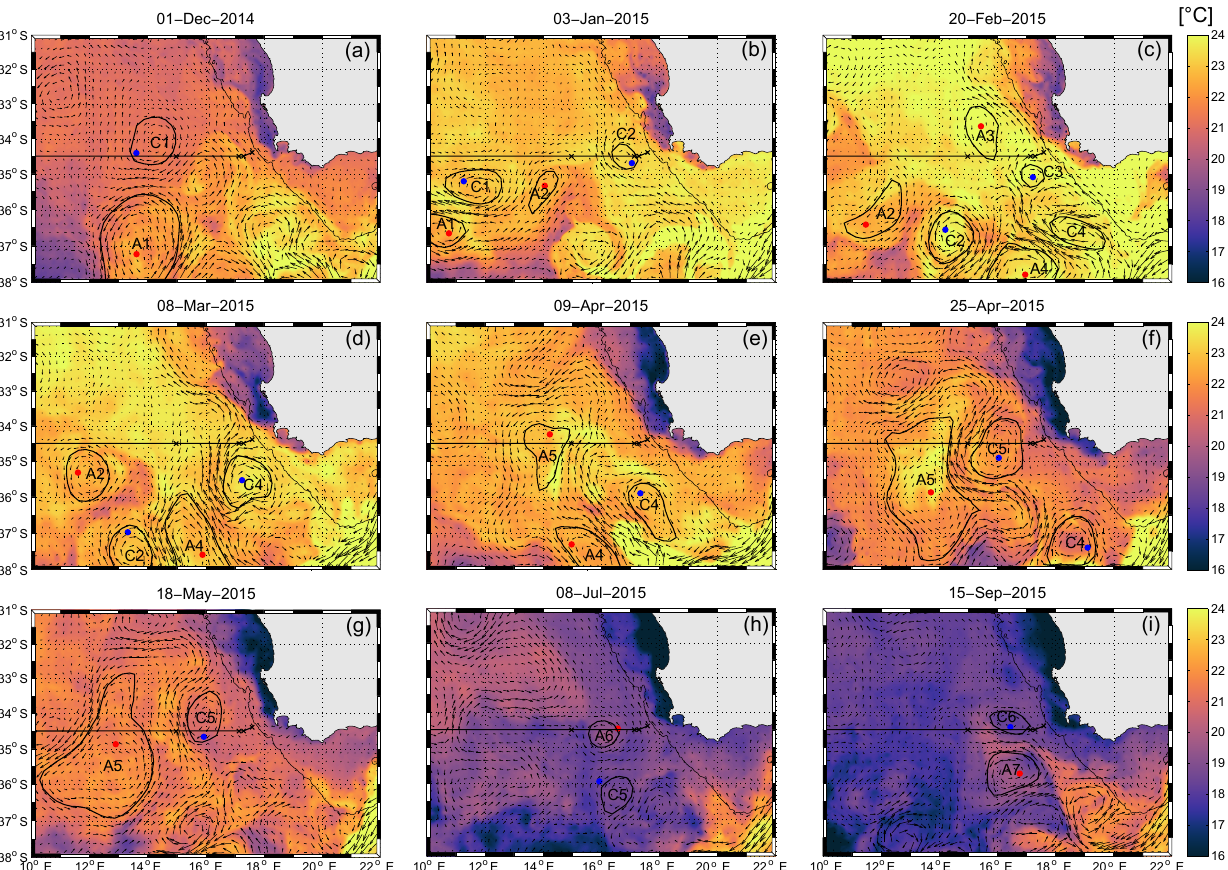
Figure 6. SST satellite images for selected dates between 1 December 2014 to 15 September 2015. The black line denotes the position of the SAMBA line, and the crosses represent the mooring positions. Black contours show the coherent core of the eddies identified by the new method of detection. The colored dots (red for anticyclonic eddy and blue for cyclonic eddy) are the eddy centers detected in the META